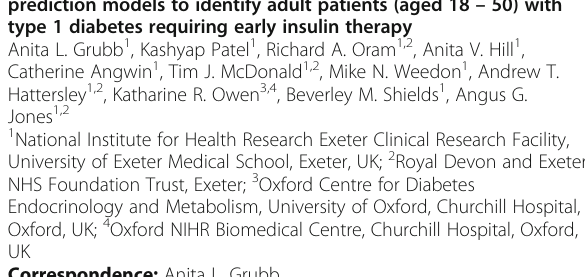
Table 2 (abstract P25). Facilitators of spin in clinical studies evaluating performance of biomarkers in ovarian cancer Potential facilitators of